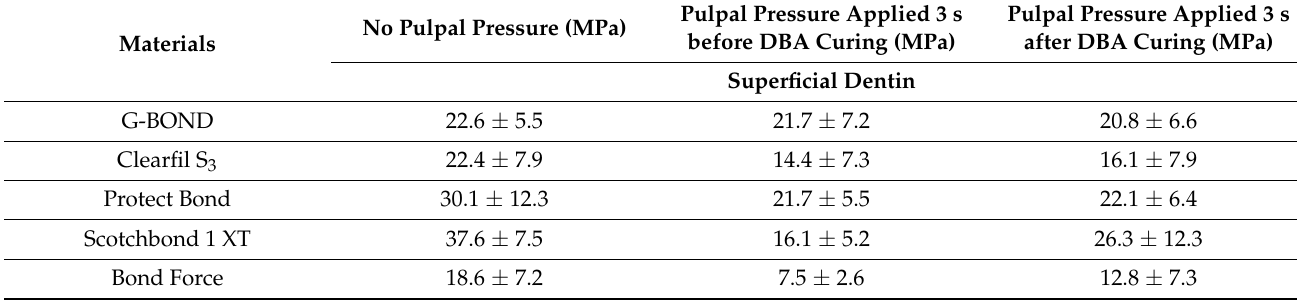
Table 2. Microtensile bond strengths (means ± standard deviations) of the DBAs bonded to superficial dentin.